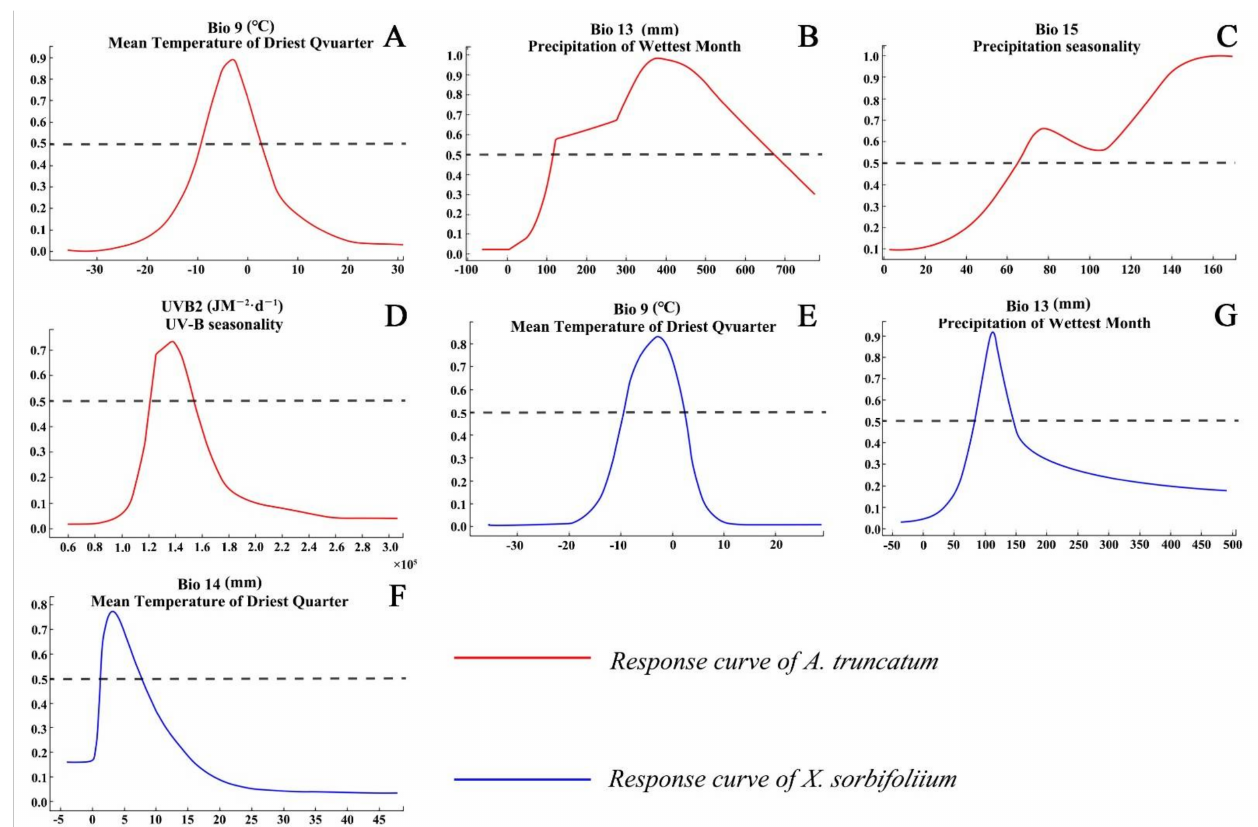
Figure 2. Response curves of the major environmental variables important for A. truncatum ( A − D ) and X. sorbifolium ( E , F ).